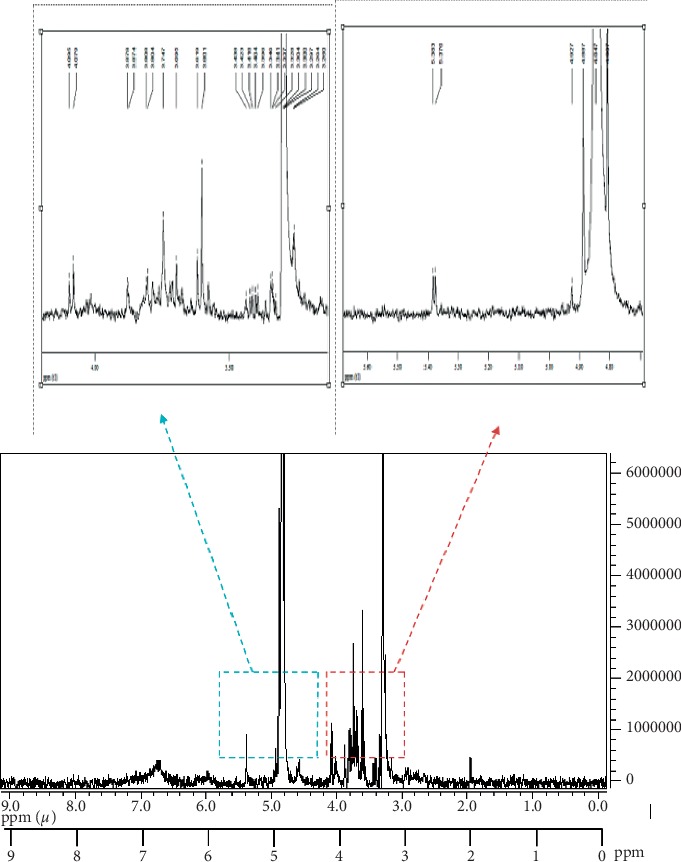
The 1H NMR (500 MHz) spectrum of F2C-d in CD3OD : D2O.